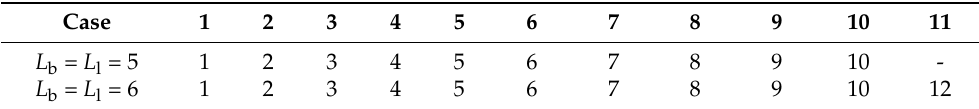
Figure 2. The configurations of coalescence of two droplets with ( a ) L b = L l = 6 nm; the center of two droplets is consistent with the center of more hydrophobic strip; ( b ) the two droplets paralleled moving towards the right by 6 nm on the basis of ( a ); ( c ) L b = 6 nm, which is fixed, while L l is changed to 10 nm, and the center of the two droplets is consistent with the fixed strip. The yellow region is the more hydrophobic strip, while the gray region is the more hydrophilic strip. Table 2. Physical dimensions of the moving length of the center of two droplets at θ l = 160 ◦ and θ b = 180 ◦